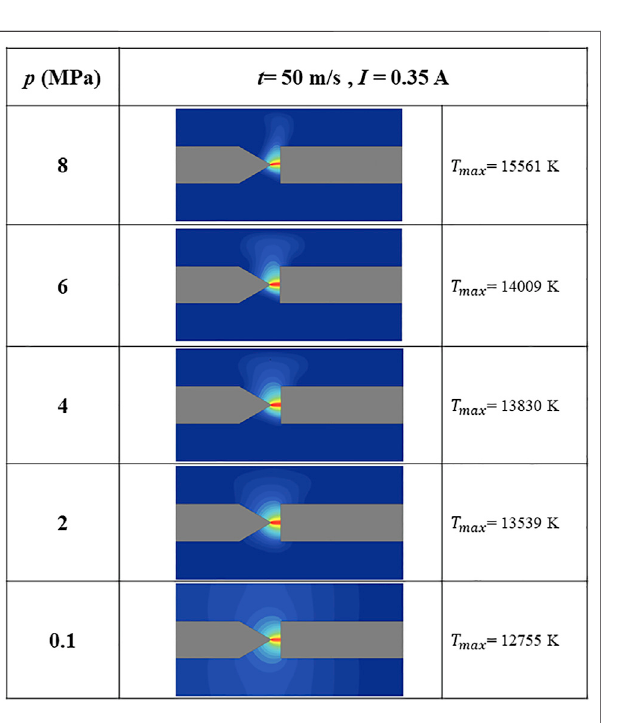
Frontiers in Physics |